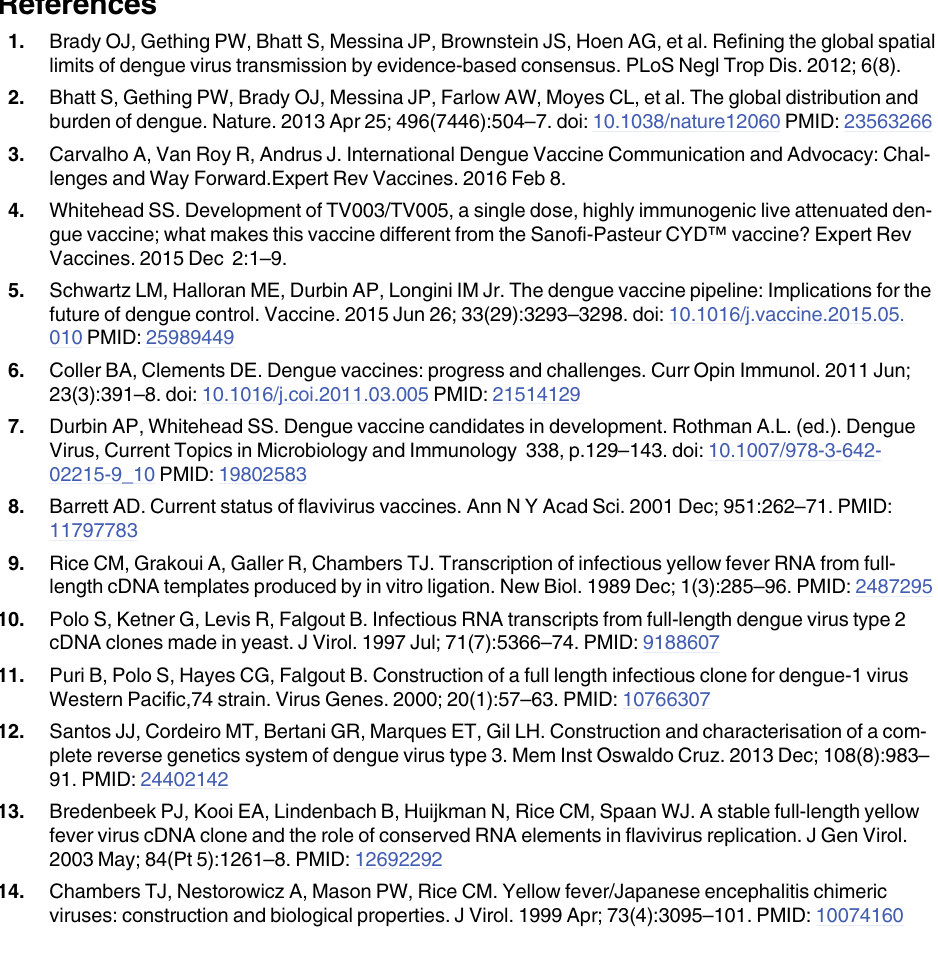
S1 Table. Neutralization titers in immunized